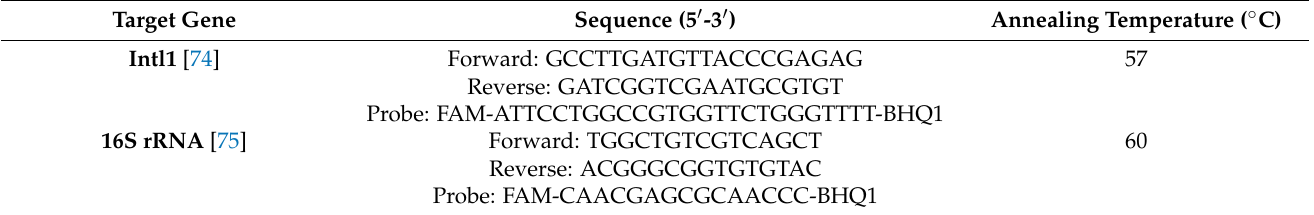
Table A3. The sequence and annealing temperature of primers and probes of the Intl1 and 16S rRNA gene used in this